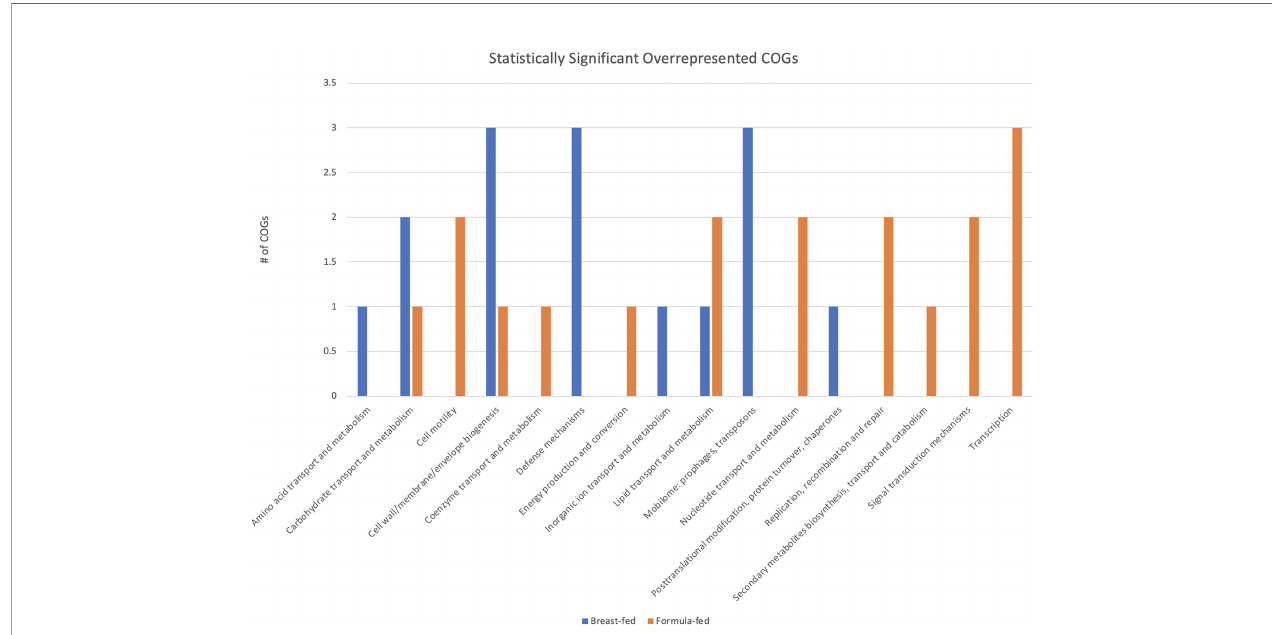
FIGURE 2 | Clusters of Orthologous Genes (COG) Category Analysis. Statistically signi fi cant and overrepresented COGs are plotted by category and number from the total 60 COGs listed in Table 2